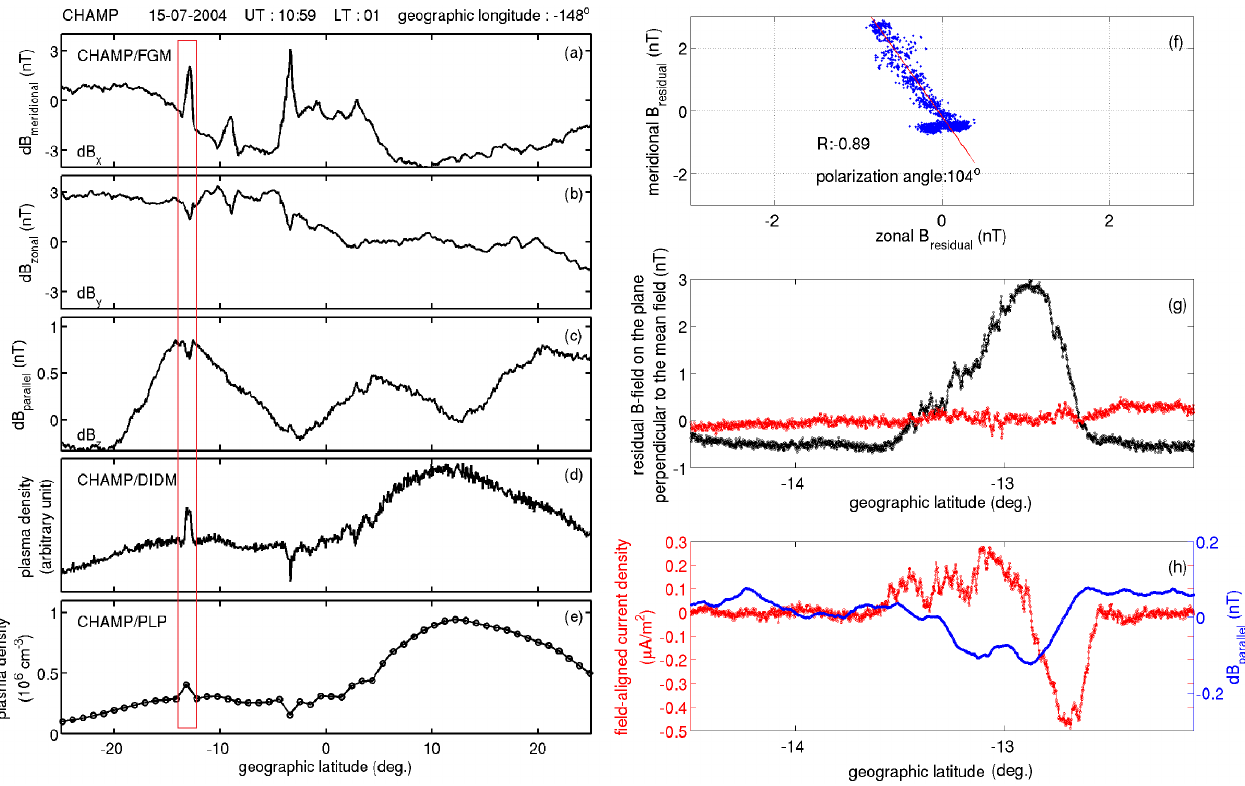
Fig. 1. A blob example observed by CHAMP: (a–c) the three components of the residual field in MFA coordinates, (d) relative plasma density measured by DIDM, (e) absolute plasma density derived from PLP, (f) hodogram of the zonal and meridional residual fields, (g) magnetic deflections along the direction of maximum variance (black curve), and minimum variance (red curve), (h) FAC density (red dots) and parallel component of the residual field (blue